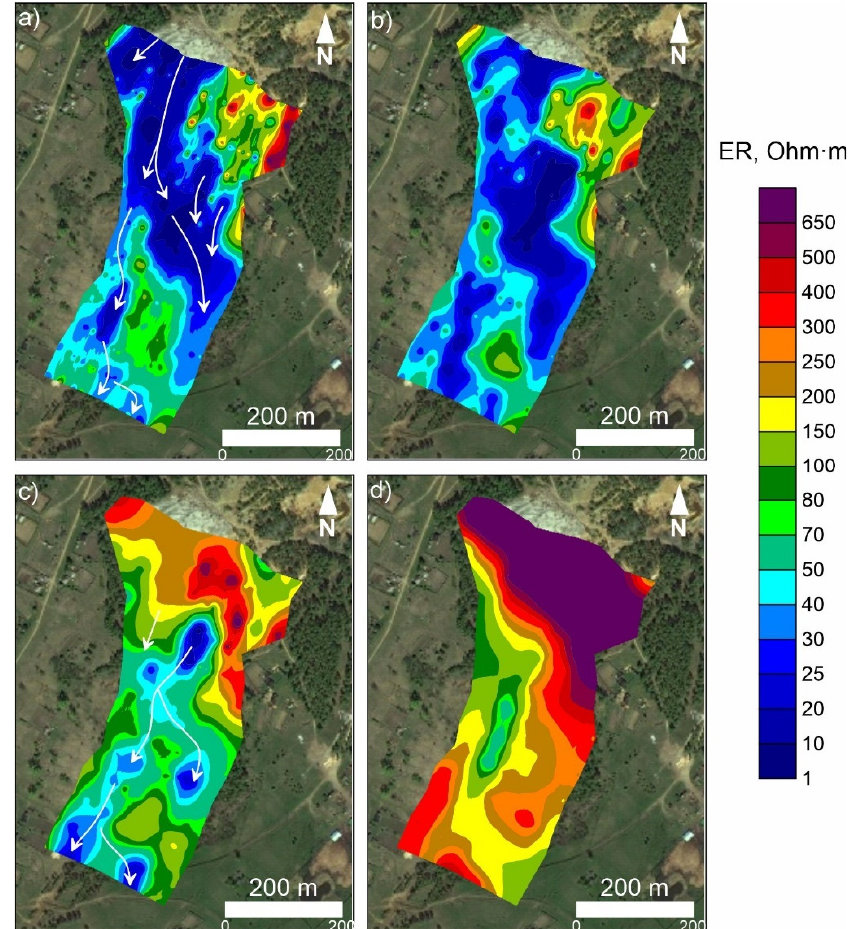
Figure 6. Maps of the distribution of the electrical resistivity of the medium in the study area at depths of 1 ( a ), 8.5 ( b ), 15.5 ( c ), and 30.5 m ( d ). The white arrows indicate the surface drainage pathways.